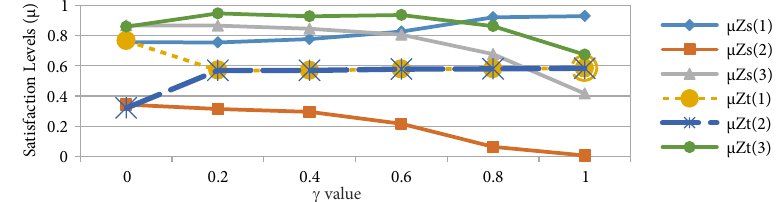
Fig. 5. Effect on satisfaction levels of the different g